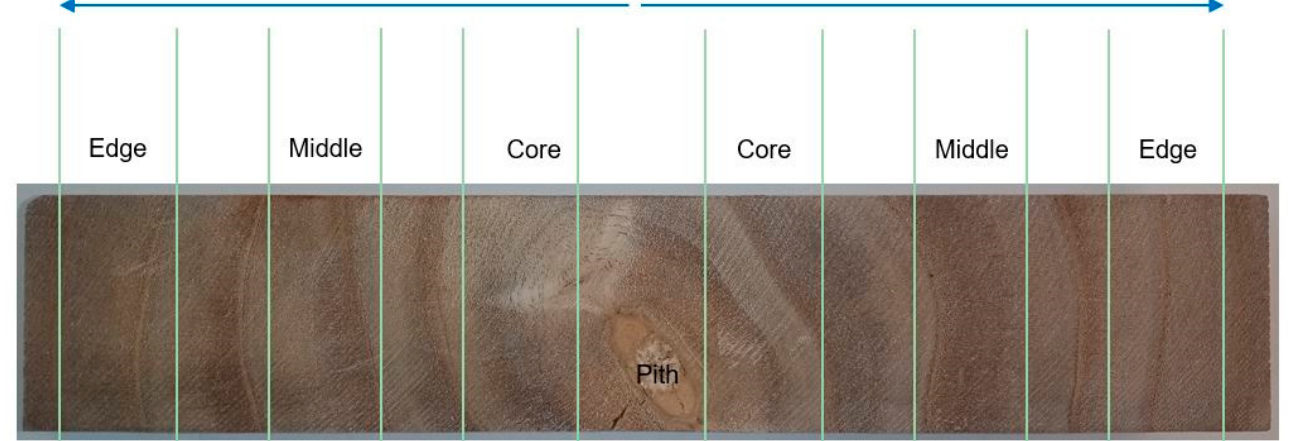
Figure 5. Radial areas from the pith to margins (core, middle, and edge) for the extraction of the